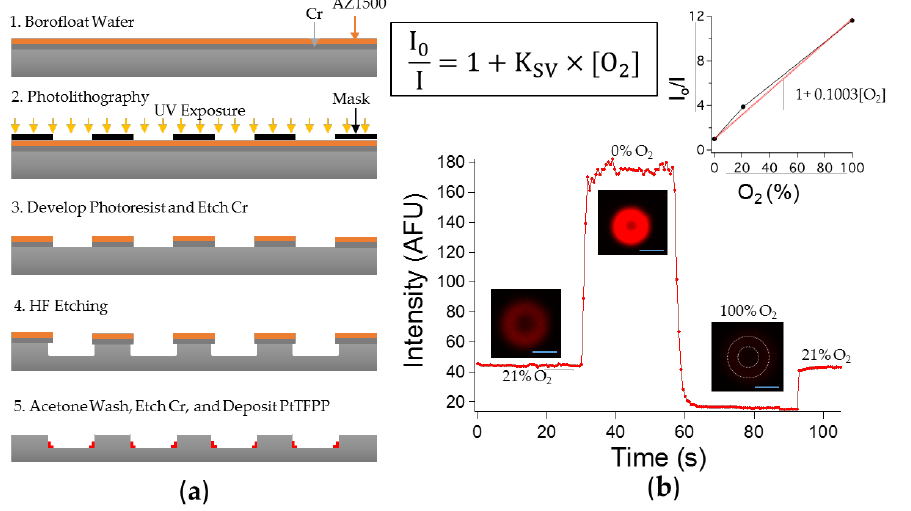
Figure 1. ( a ) Overview of the device fabrication scheme; ( b ) Testing the oxygen sensitivity of a device by measuring the phosphorescent intensity. Three gas lines were used: 21% O 2 (house air), 0% O 2 (100% N 2 ), and 100% O 2 . The top left inset is the Stern-Vollmer equation, outlining the inverse relationship between the intensity and the oxygen concentration with I 0 representing the intensity at 0% O 2 . Images of the microchamber were set at the same contrast level. At 100% oxygen, the red intensity was indiscernible at the chosen contrast level so an outline of the chamber was included. Top right inset is the plotted average measured intensities (I 0 /I with I 0 being the intensity at 0% O 2 ) at three different oxygen concentrations and the fitted line for Stern-Vollmer relationship. Scale bar is 10 µm.